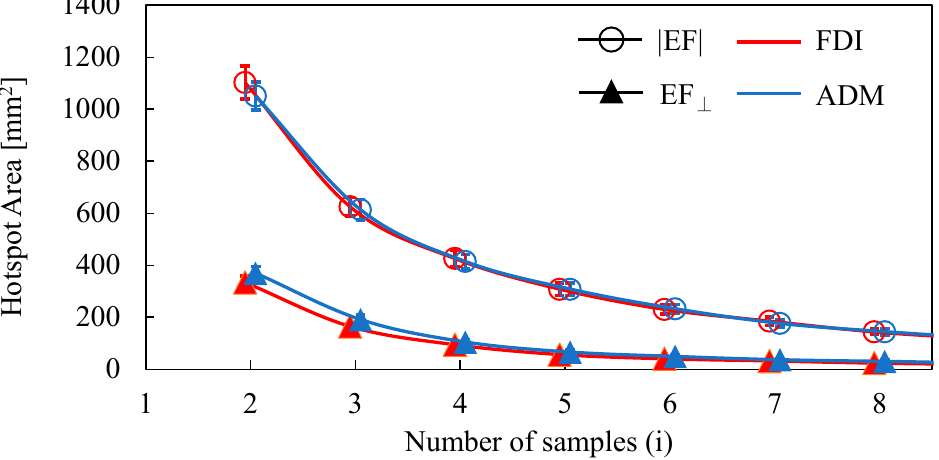
Figure 2. Dependence of the hotspot area on the number of samples when using the amplitude of the electric field (|EF|) and the normal component of the electric field to the wall (EF ⊥ ).